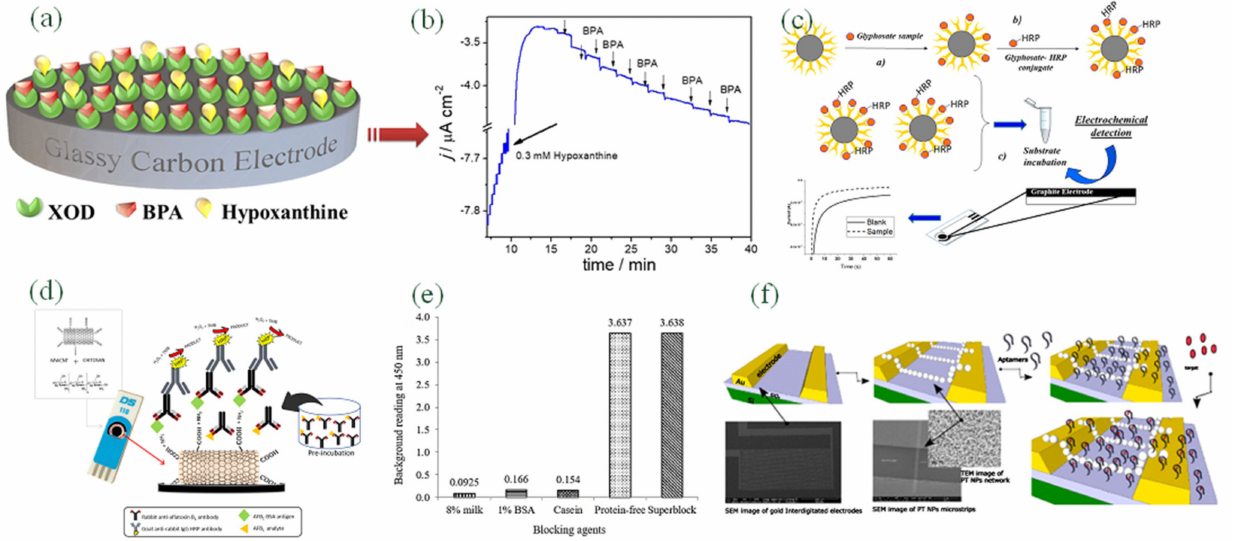
Figure 1. ( a , b ) Amperometric response of B.P.A. at XOD/GCE in the presence of 0.3 mM hypoxanthine (Reproduced with the permission from [53]); ( c ) Schematic of magnetic beads (MBs) for the analyte and its capturing technique on the electrode surface (Reproduced with the permission from [54]); ( d ) The complete schematic diagram of the nanomaterial-based immunosensor based on ELISA indirect competitive format (Reproduced with the permission from [55]); ( e ) Effect of various blocking agents on background reading by eight percent skimmed milk, one percent BSA, casein, protein-free, and superblock (Reproduced with the permission from [56]); ( f ) Schematic representation, SEM and EIS responses of the fabricated aptasensor (Reproduced with the permission from